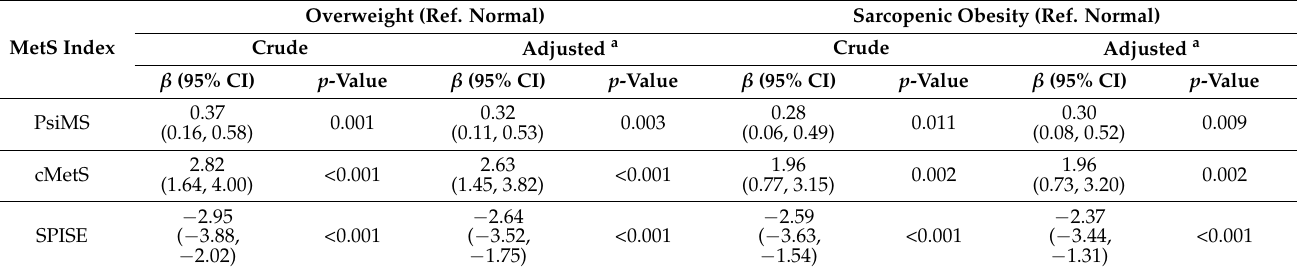
Table 4. Multiple linear regression results for the effect of childhood overweight and sarcopenic obesity groups on the metabolic syndrome index in adolescence.